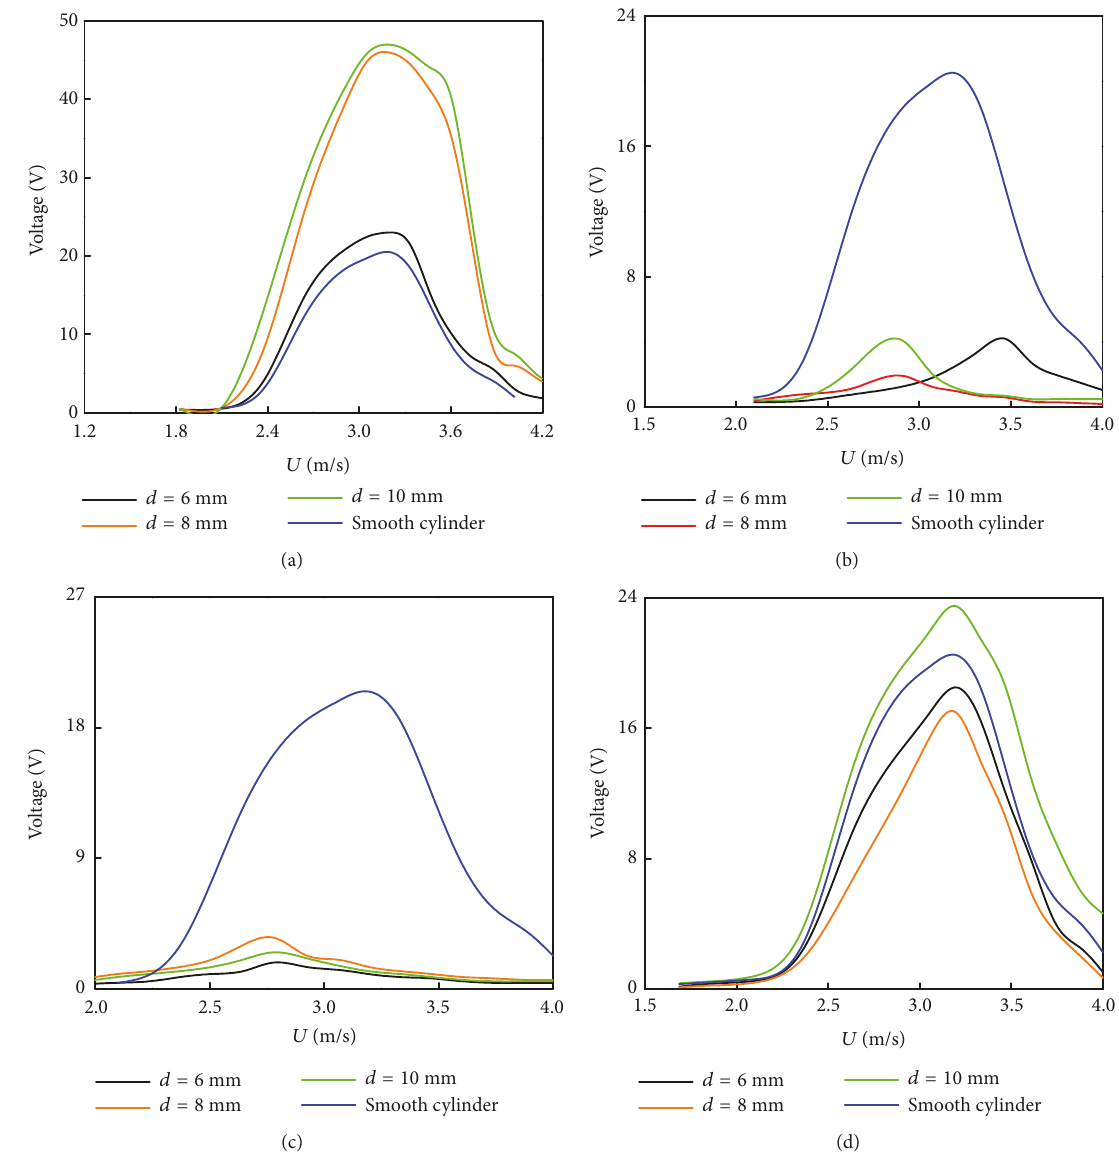
Figure 9: Measured piezoelectric energy harvester data (no resistance): (a) peak voltage versus wind speed of 3-column hemisphere protrusion; (b) peak voltage versus wind speed of 4-column hemisphere protrusion; (c) peak voltage versus wind speed of 5-column hemisphere protrusion; (d) peak voltage versus wind speed of 6-column hemisphere